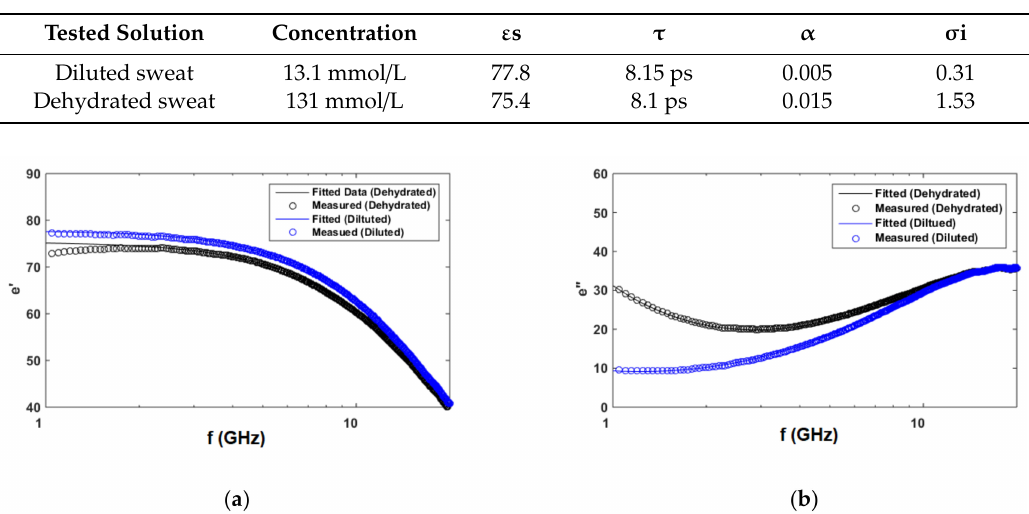
Table 4. Cole–Cole parameters of artificial sweat mixtures obtained by fitting the experimental data collected from 1 to 20 GHz and at 23 ◦ C to a Cole–Cole model.